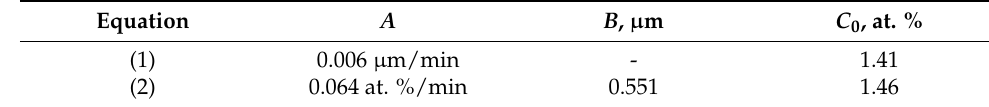
Table 1. Constant coefficients of equations (1) and (2) for the studied films.